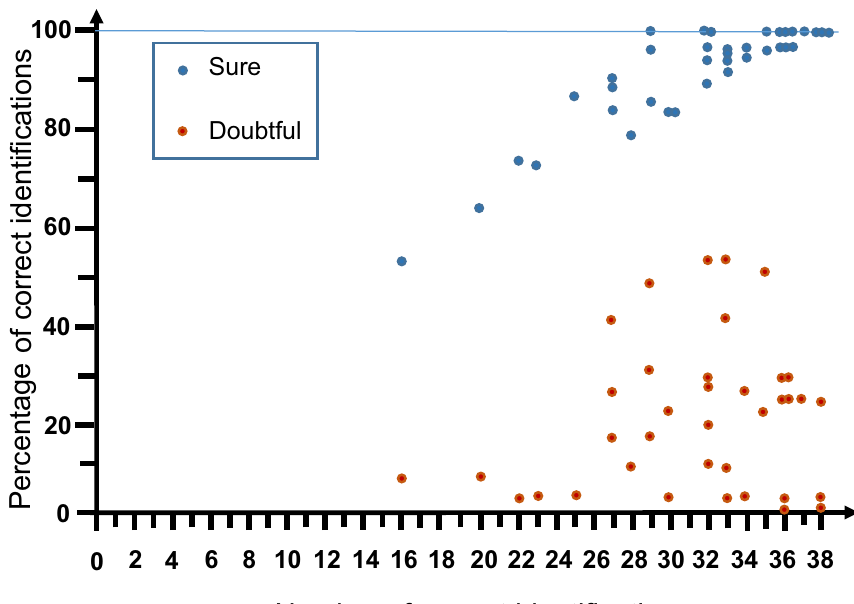
Figure 4. Distribution of the percentage of correct identi fi cations estimated by the responder to be “ sure ” or “ doubtful ” with regard to the number of correct identi fi cations for 38 mosquitoes (grouped for 26 females plus 12